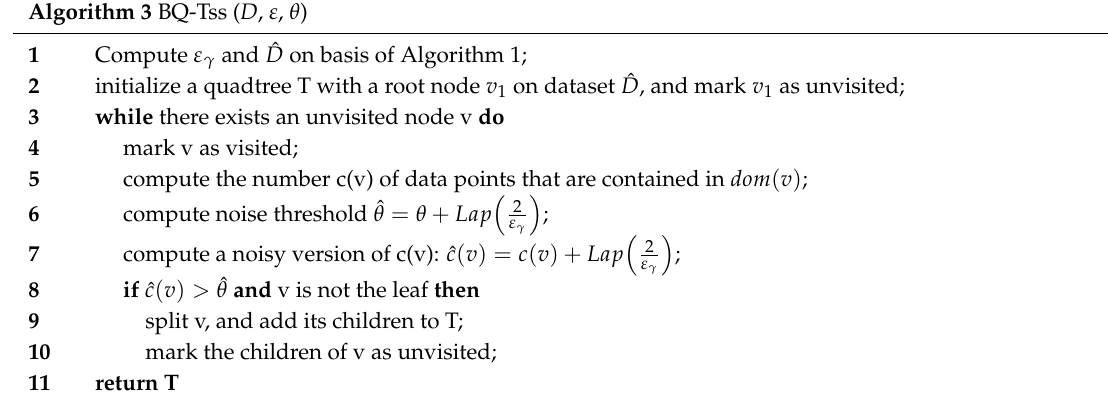
Algorithm 3 BQ-Tss ( D , ε , θ